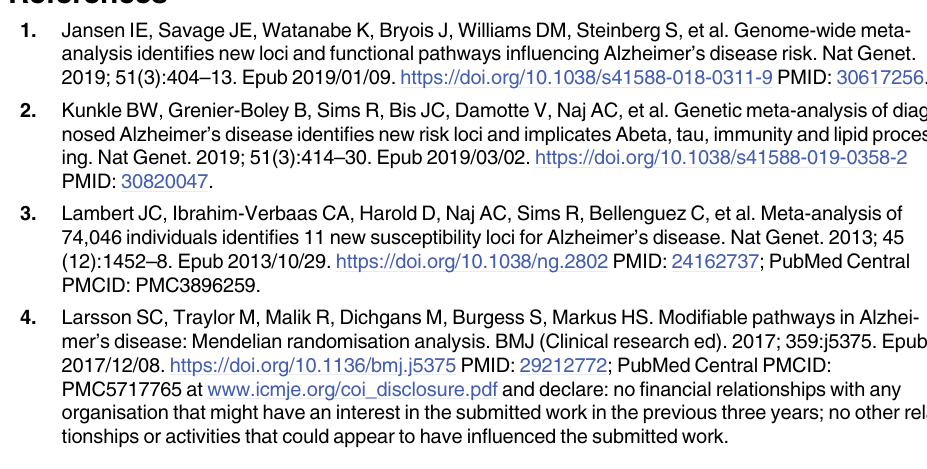
S2 Table. Summary statistics for Mendelian randomization analysis of potential causal effect of Alzheimer’s disease on periodontitis. S1 Fig. Leave-one-out Mendelian randomization (MR) estimates. (A) Periodontitis on risk of Alzheimer’s disease using instrumental SNPs from Munz et al . (B) Periodontitis on risk of Alzheimer’s disease using instrumental SNPs from Shungin et al . (C) Alzheimer’s disease on risk of periodontitis. MR estimates were calculated using the inverse-variance weighted (IVW) method in a random effects model after excluding each individual single-nucleotide polymor- phism (SNP). The scale on x-axis represents ln [odds ratio (OR)] for the risk of the outcome per genetically determined 1-unit increase in ln (OR) of the exposure. The dots represent the MR estimates and the lines represent 95% confidence interval of the estimates. AD: Alzhei- mer’s disease; MR: Mendelian